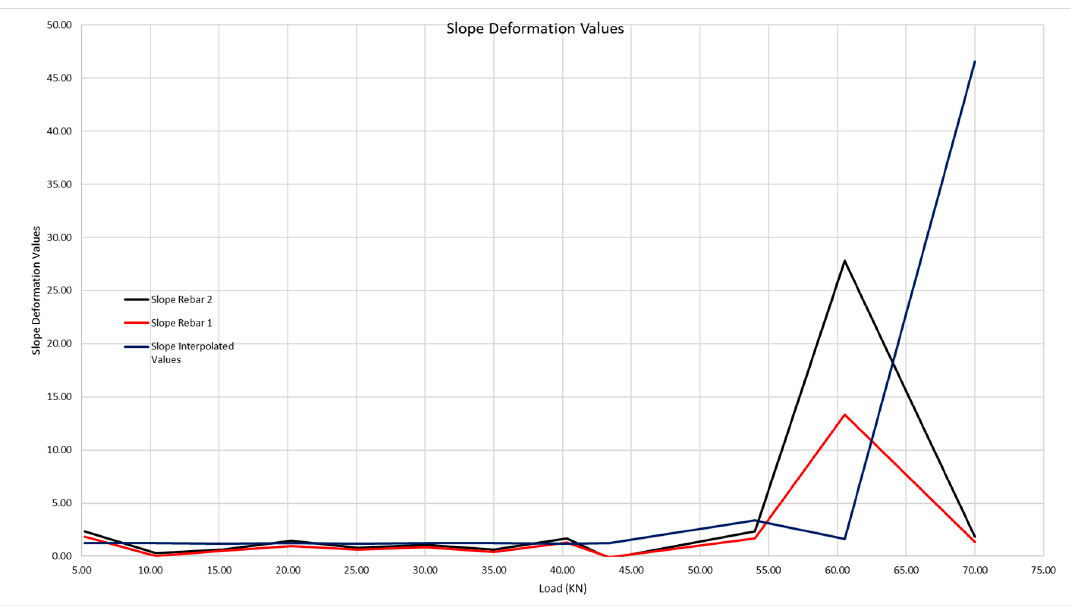
Figure 27. Detail of the first crack forming in the 300 × 500 mm beam.